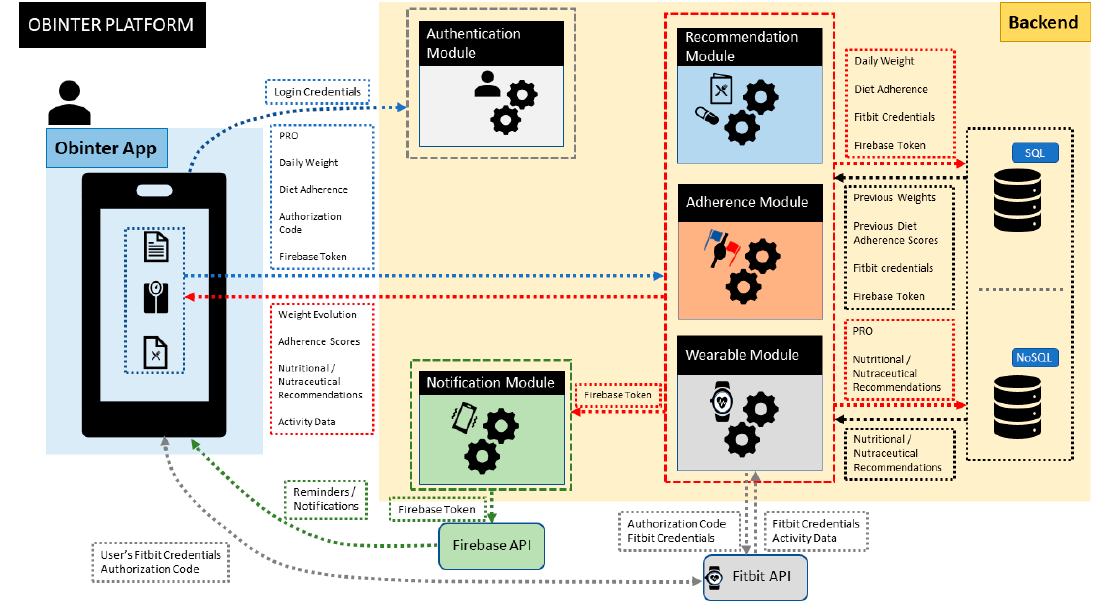
Figure 2. High-level abstraction of OBINTER platform architecture. The OBINTER platform is composed of two main physical blocks (i.e., Obinter App and Backend) together with the Firebase API (for notifications) and Fitbit API (for wearable data integration). Next, the different modules depicted within the backend represent the logical functionalities implemented by the OBINTER platform.